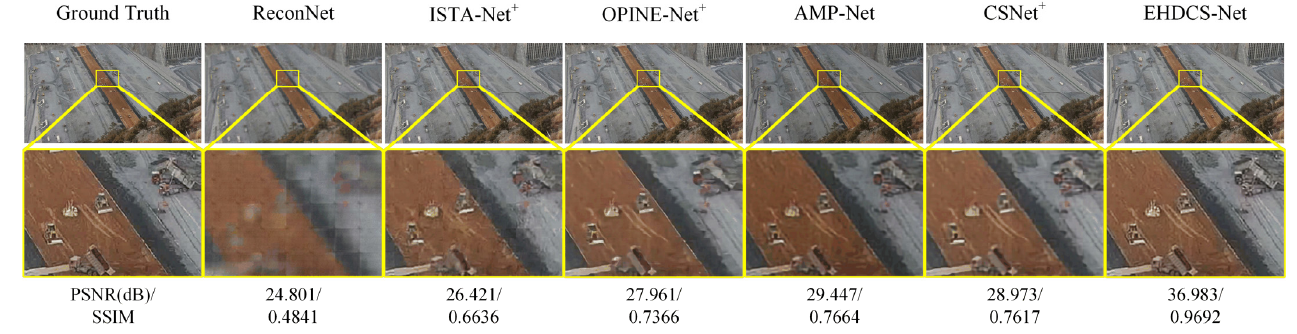
Figure 12. Visual quality comparison of large-scene construction site monitoring image CS recovery of different deep learning-based image CS methods in the case of CS ratio = 0.1.